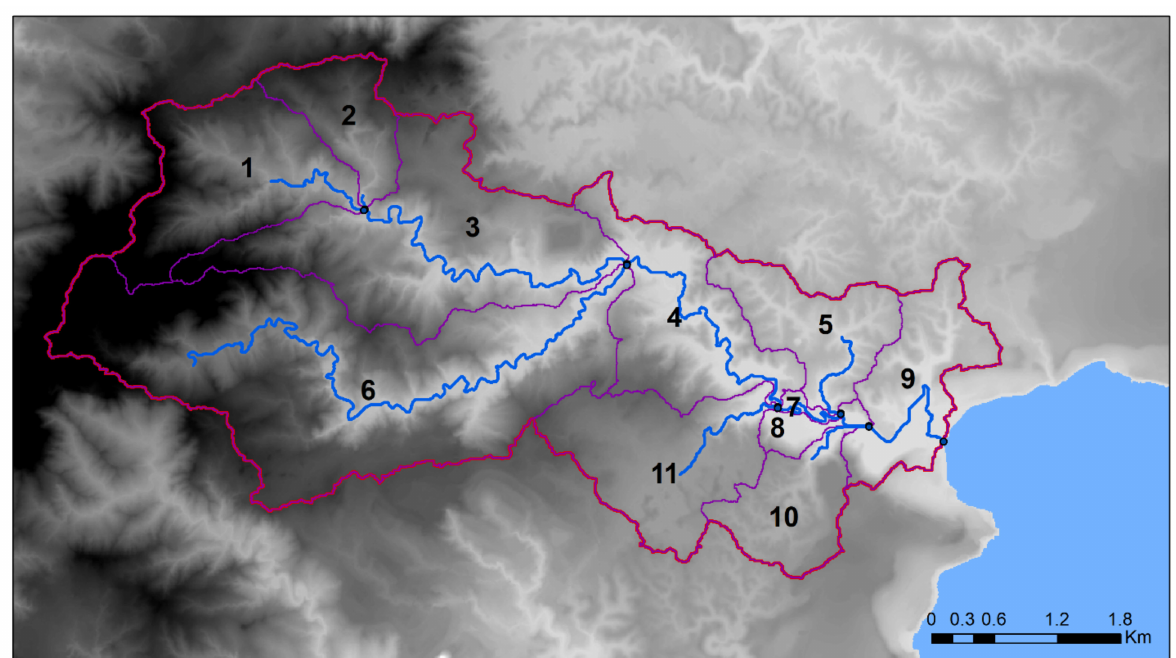
Figure 3. Delineated 11